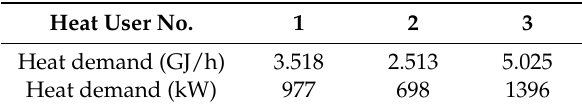
Figure 2. The layout of a DH network (the solid and dashed lines denote the supply and return pipes). Table 1. The design heat demand profile for all heat users.